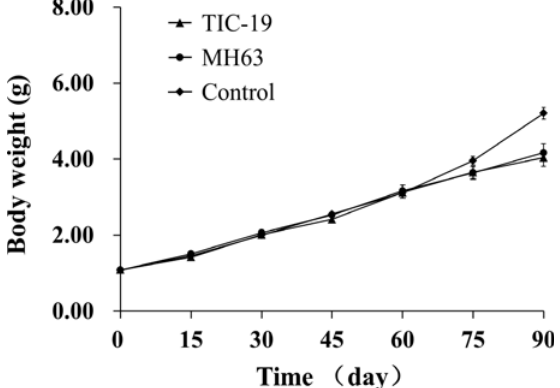
Fig 2. The growth curves of Xenopus laevis froglets (body weight) when fed diets containing transgenic cry1Ca rice (T1C-19) or non-transformed rice isoline (MH63) grains, or a blank control diet for 90 days (n =